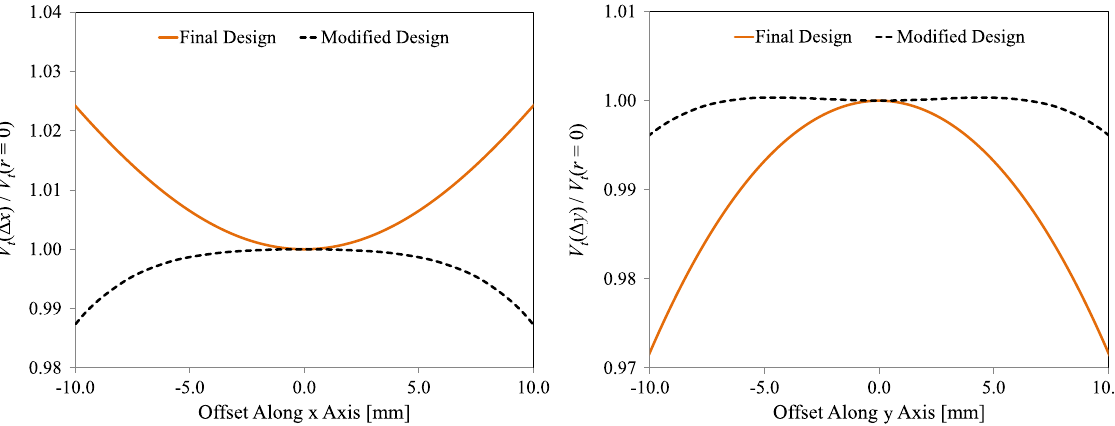
FIG. 30. Normalized transverse deflecting voltage in horizontal (offset along x axis) and vertical (offset along y axis) directions for Design (F) shown in Fig. 8 and modified rf-dipole design shown in Fig.